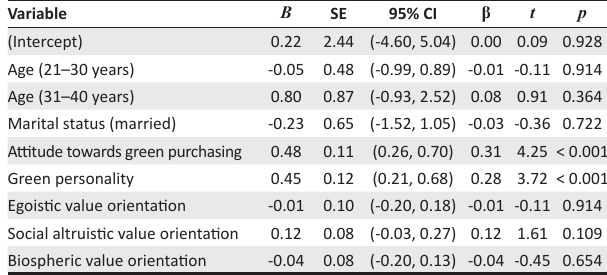
TABLE 6: Results of the multiple regression model (female respondents). TABLE 5: Results of the multiple regression model (male respondents).